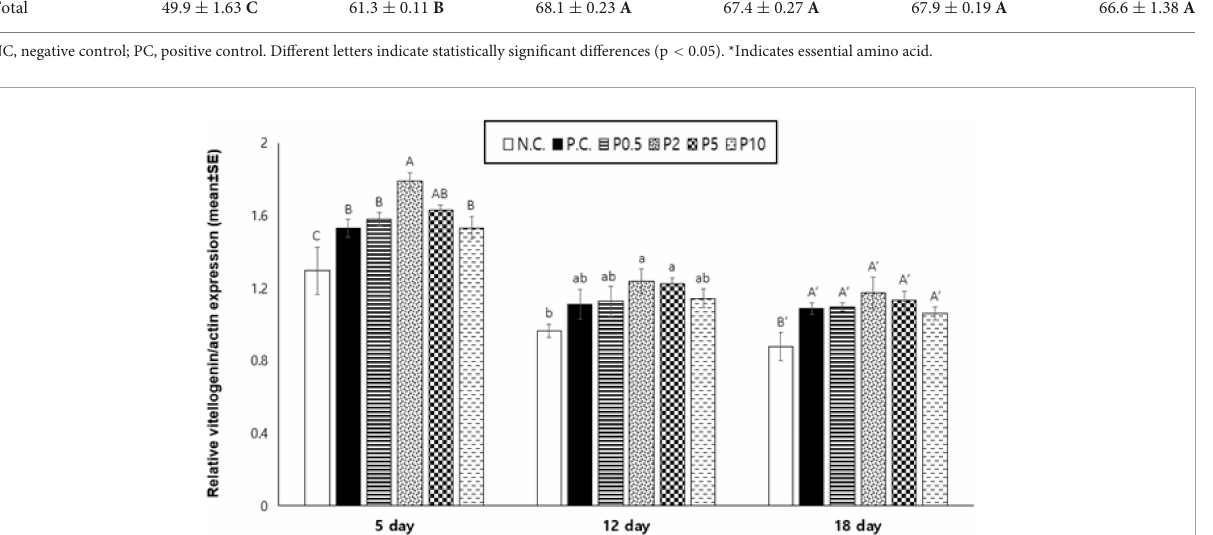
different proteolytic activities depending on their age and